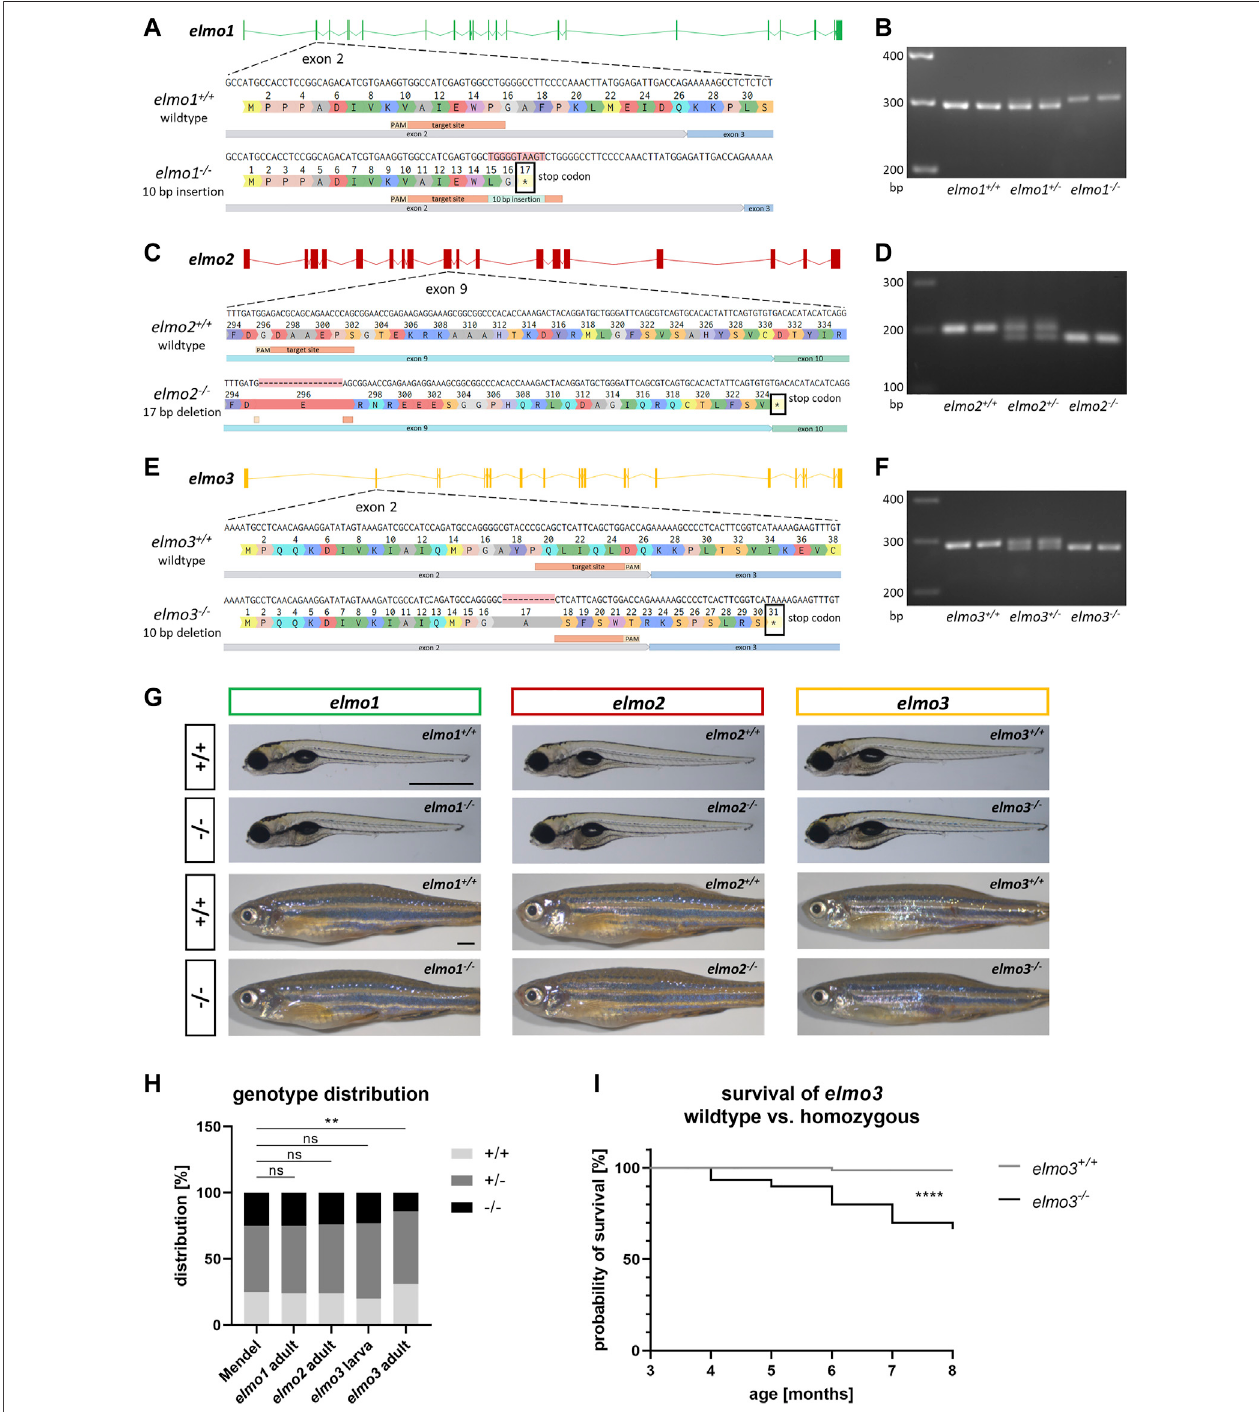
FIGURE 1 | Generation of elmo1 , elmo2 and elmo3 knockout zebra fi sh lines. (A) Exon map of the zebra fi sh elmo1 gene and the position of the CRISPR target site designedforzebra fi sh elmo1 targetingexon2.SequencingresultsofcDNAsequenceandtheresultingaminoacidsequencefrom elmo1 +/+ andthegenerated elmo1 − / − line with a 10 bp insertion. The resulting stop codon is indicated with a star. (B) The 10 base pair insertion in elmo1 was con fi rmed on RNA level by gel electrophoretic segregation of PCR products of cDNA which was synthesized from mRNA from elmo1 +/+ , elmo1 +/ − and elmo1 − / − larvae at 120 hpf. PCR product size: wild type 298 bp, homozygous 308 bp. (C) Exon map of the zebra fi sh elmo2 gene and the position of the CRISPR target site designed for zebra fi sh elmo2 targeting exon 9. Sequencing results of cDNA sequence and the resulting amino acid sequence from elmo2 +/+ and the generated elmo2 − / − line with a 17 bp deletion. The resulting stop codonisindicatedwithastar. (D) The17basepairdeletionin elmo2 wascon fi rmedonRNAlevelbygelelectrophoreticsegregationofPCRproductsofcDNAwhichwas